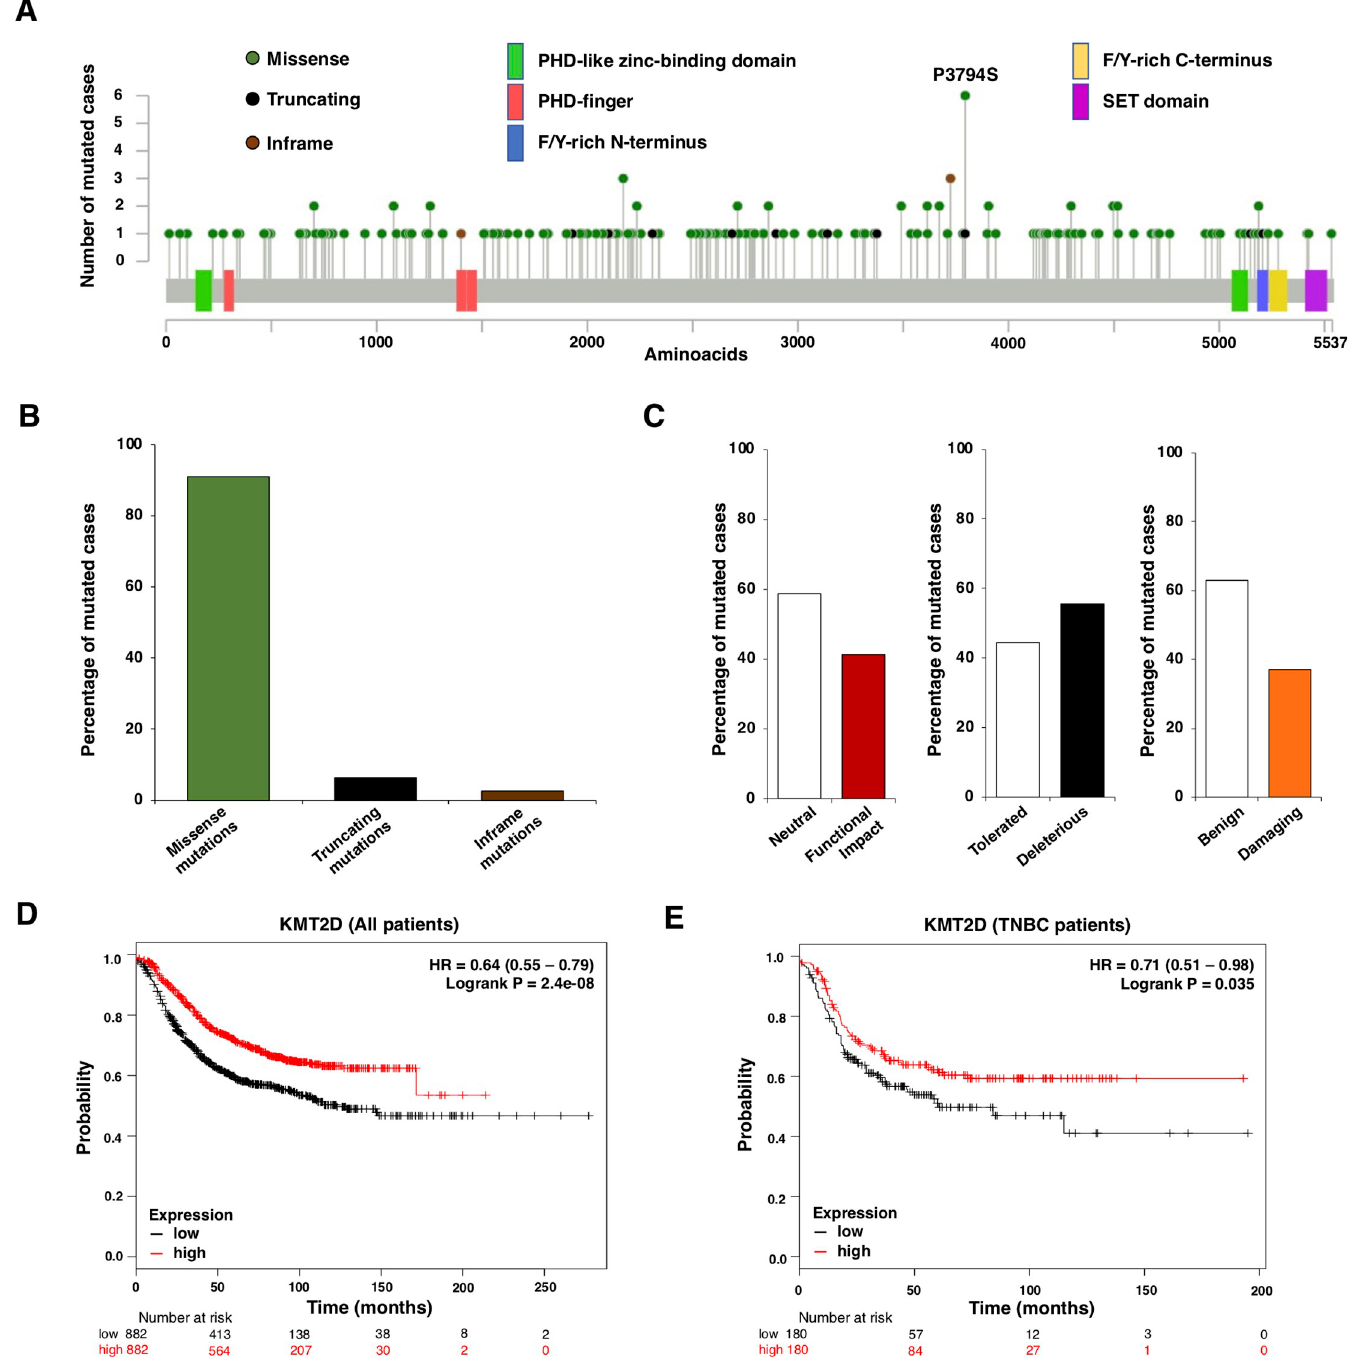
Fig 5. Assessment of mutations at KMT2D . A. Diagram showing each aminoacid (aa) which can be found to be mutated in the KMT2D gene. B. Type of mutations from the included cases. C. Functional impact of KMT2D mutations in the included cases. D. Relapse free survival (RFS) of breast cancer patients based on the transcriptomic expression of KMT2D . Low expression is associated with poor outcome. E. Relapse free survival (RFS) of triple negative breast cancer patients based on the transcriptomic expression of KMT2D . KM plotter online tool was used for these prognosis analyses. Low expression is associated with poor outcome.